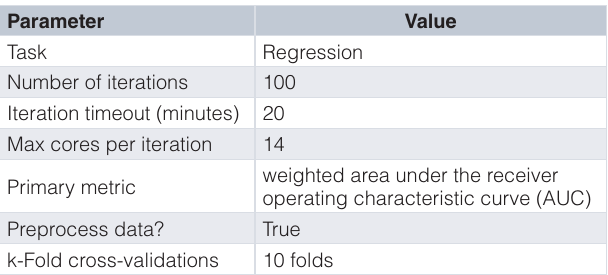
Table 9. Model search parameter settings for the clearance rate model search.